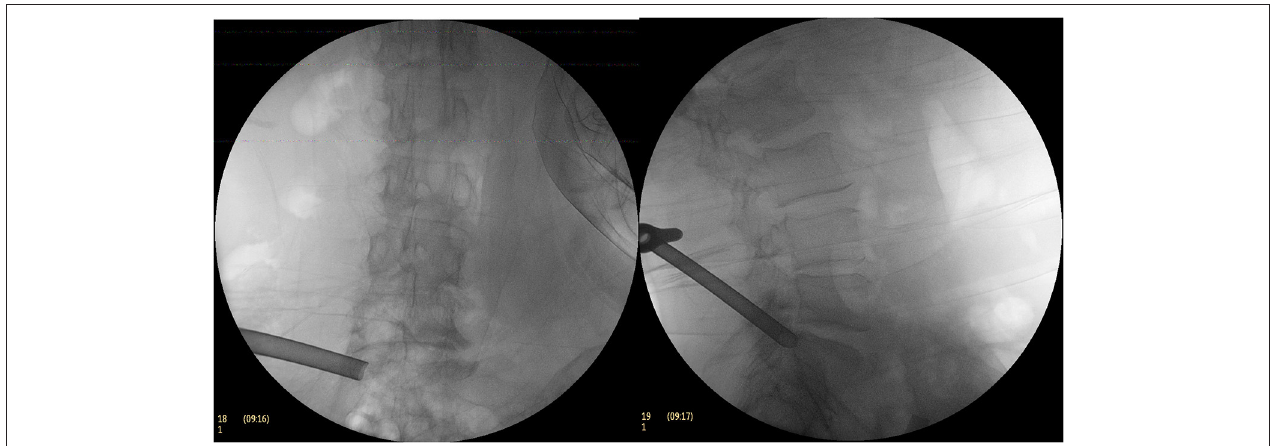
FIGURE 4 | During the operation, working cannula was placed in C-arm fluoroscopy.